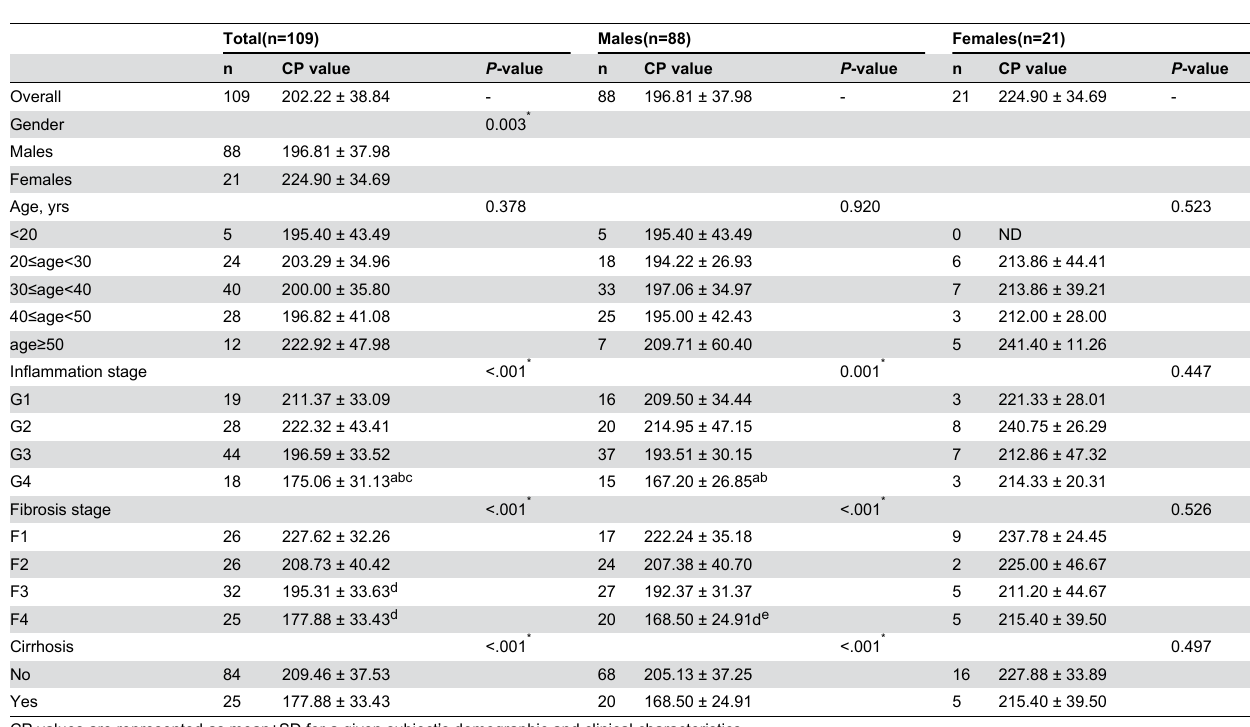
Table 3. Association of CP value with corresponding subjects’ demographic and clinical characteristics